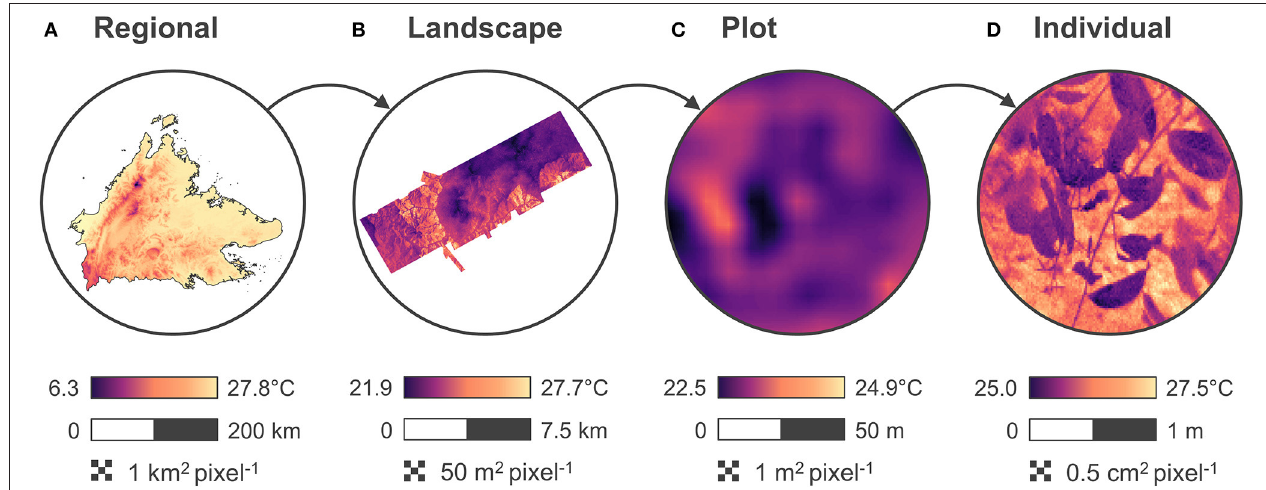
FIGURE 1 | Examples of temperature data at progressively finer spatial scales and resolutions. (A) Illustrates variation in mean annual temperature across the Malaysian state of Sabah in Borneo derived from interpolated weather station data and available through the WorldClim2 database (Fick and Hijmans, 2017). (B) Shows variation in below-canopy mean daily temperature across the SAFE project modeled by integrating data from a network of microclimate sensors with LiDAR (Jucker et al., 2018). (C ) Captures variation in near-surface mean daily temperature across a 1-ha logged forest plot within the SAFE landscape generated by interpolating data from a grid of 72 microclimate data loggers (Blonder et al., 2018). (D) Is a thermal image obtained using a FLIR model E40 camera in a selectively logged forest in Sabah (Senior et al.,